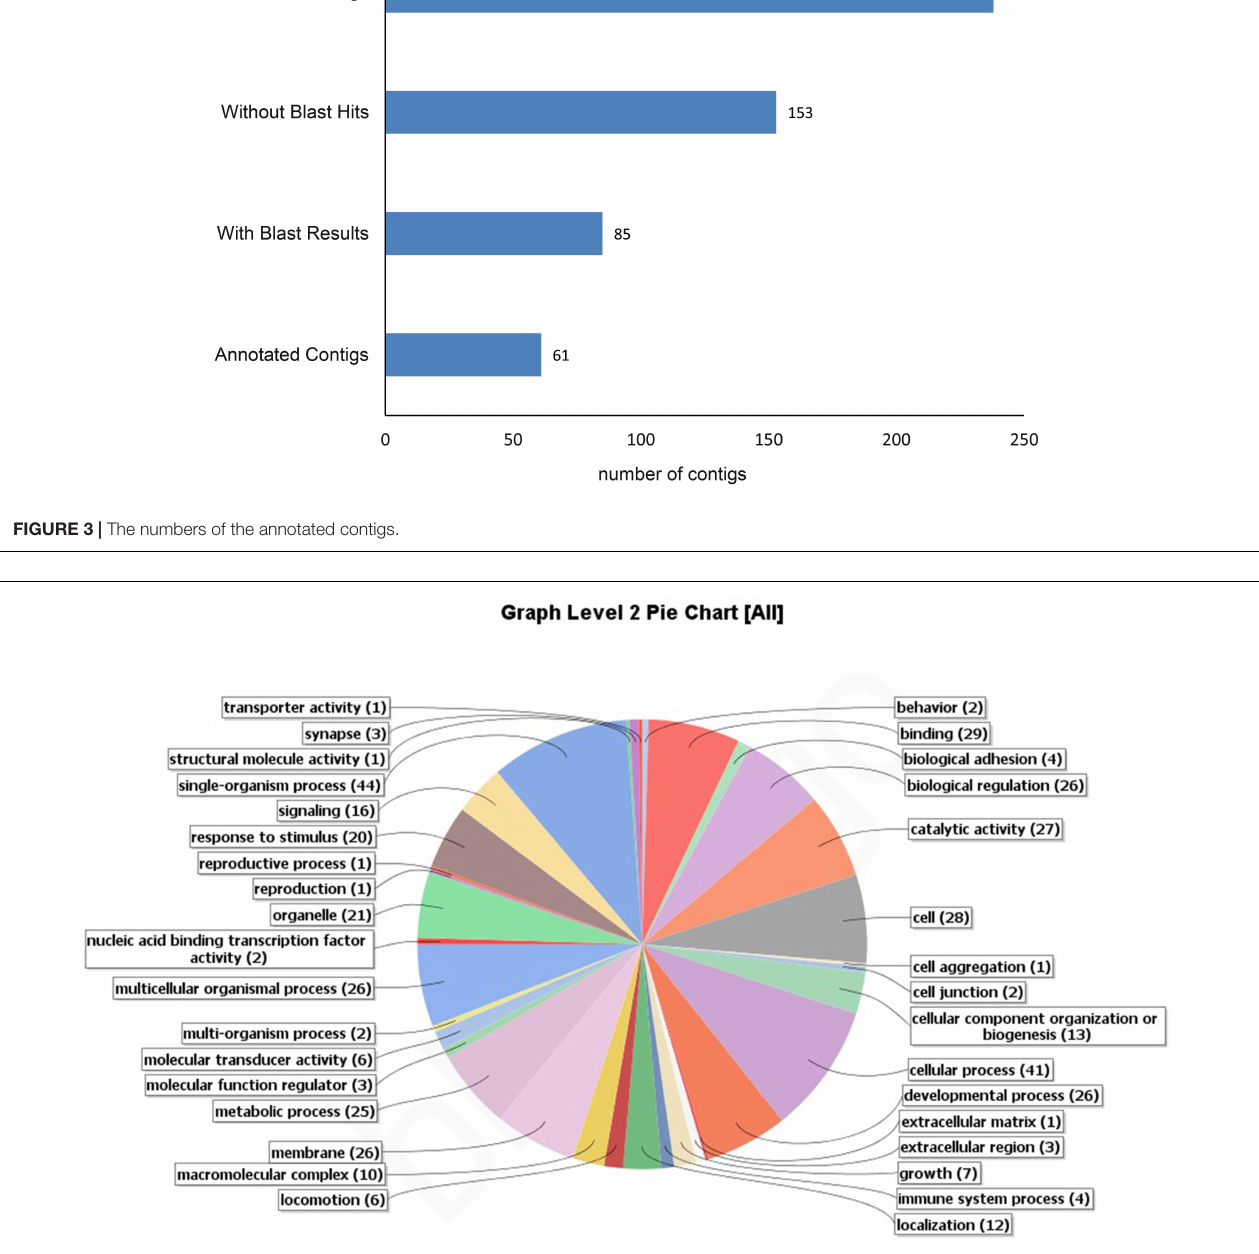
FIGURE 4 | Putative functional categorization and distribution of 61 significant BLAST hits ( E -value ≤ 1E-5) of Anguilla japonica according to BLAST2GO